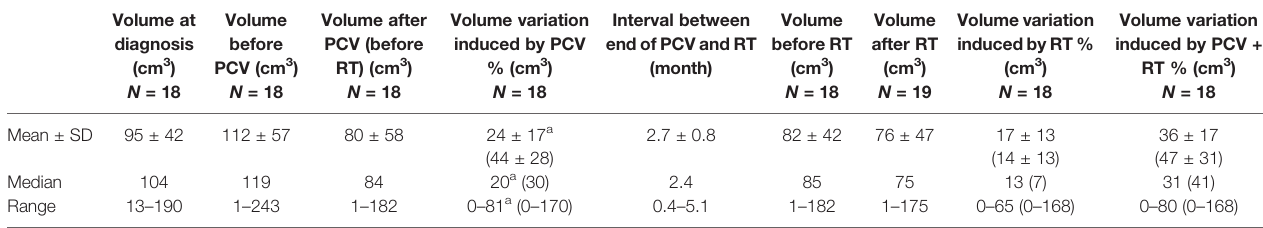
TABLE 2 | Tumor volumes before, during, and after the combined therapy.